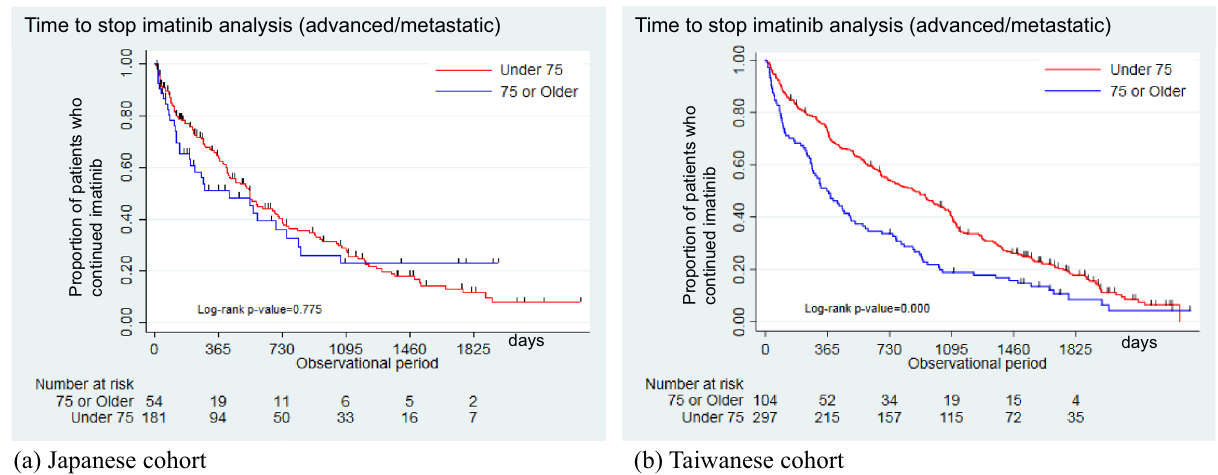
Figure 3. Time to stop imatinib in the older and non-older patients with advanced/metastatic tumors. ( a ) Japanese cohort. ( b ) Taiwanese